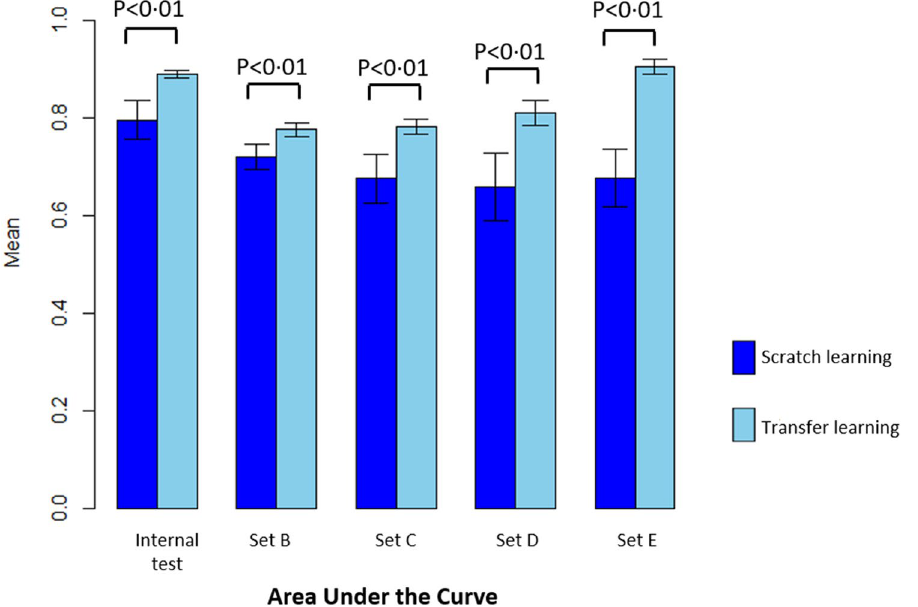
Figure 3. Comparing the mean AUC with standard deviation between scratch learning and transfer learning in five data